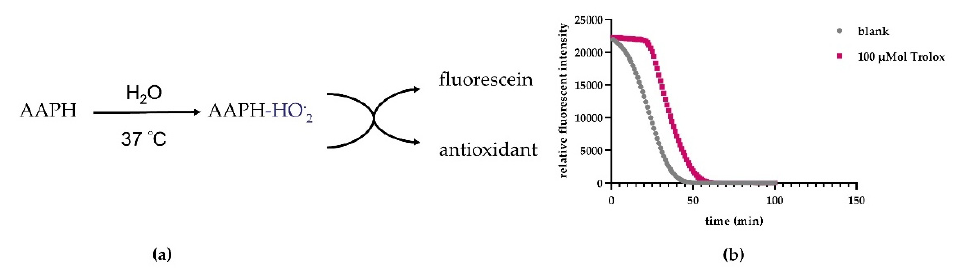
Figure 11. ( a ) Primary reaction of ORAC assay and ( b ) time-dependent fluorescence decay curve with and without antioxidant (Trolox). with and without antioxidant